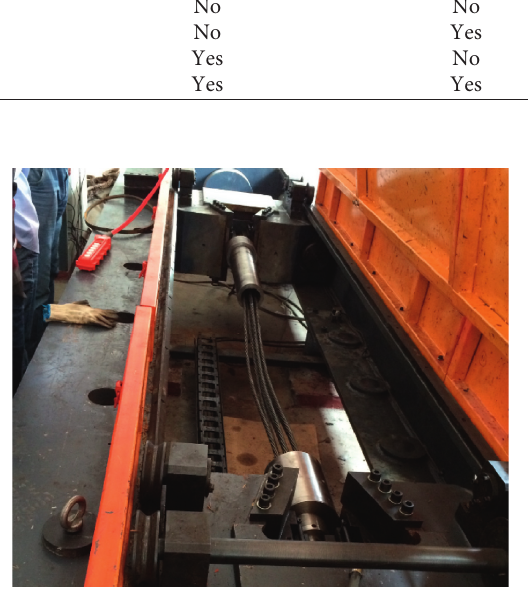
Figure 7: Static tensile